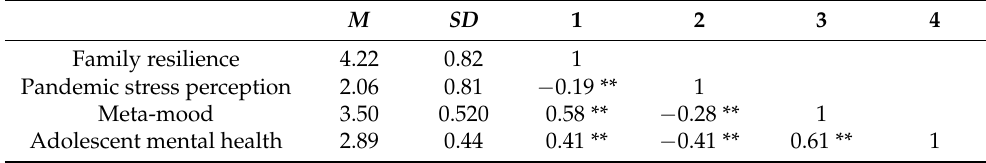
Table 7. Correlation analysis among variables ( N = 2691).